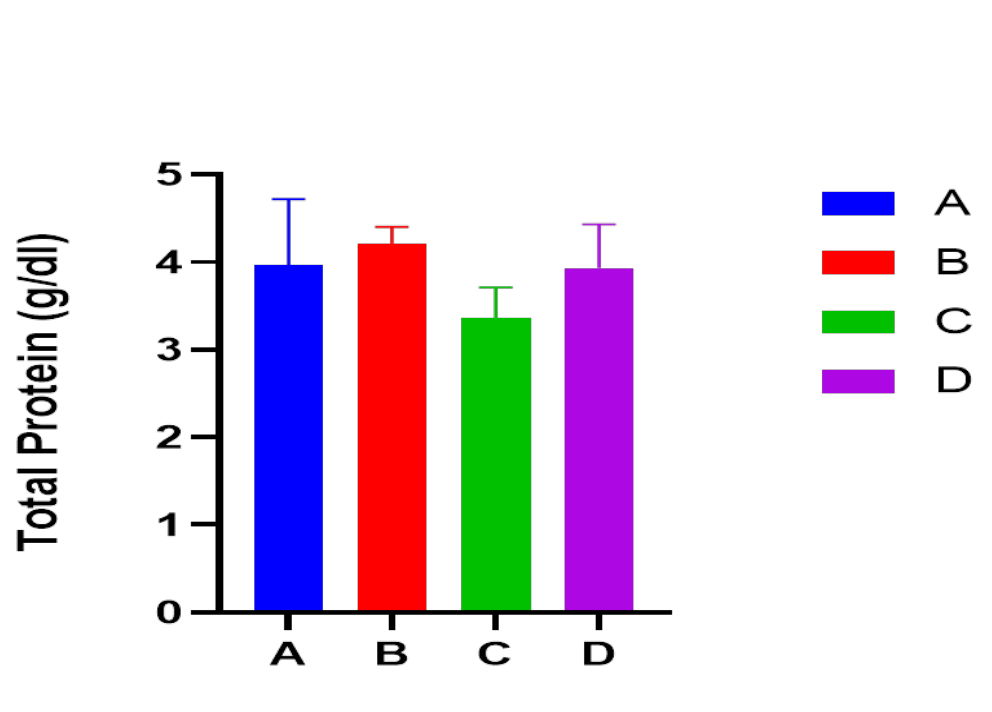
Key: A = T B = T C= T D = T C, 1, 2, 3